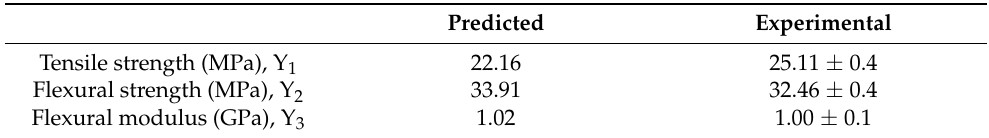
Table 5. Comparison between predicted and experimental values of P(HB- co -11% HHx)/CNF bionanocomposites fabricated at optimal conditions.